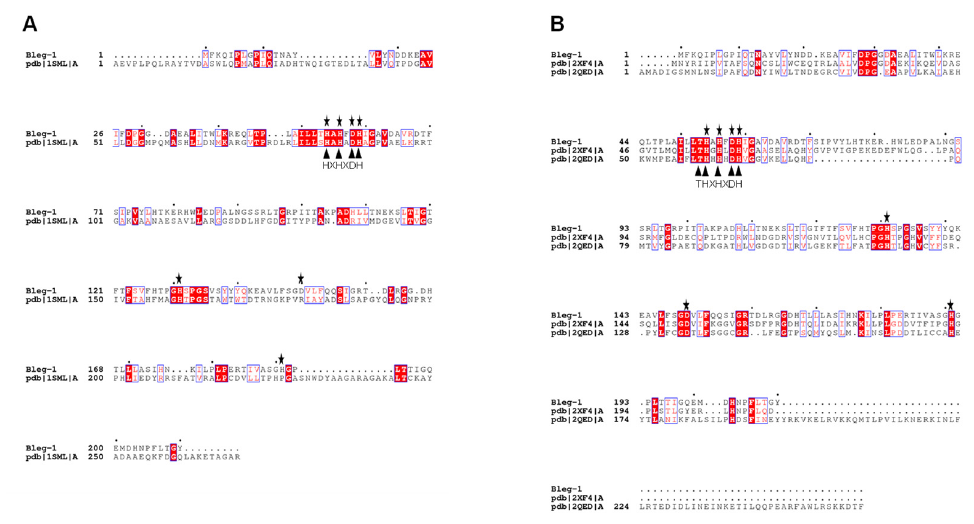
Figure 3. Pairwise sequence alignment of BLEG-1 with ( A ) L1 B3 MBL from Stenotrophomonas maltophilia (PDB ID: 1SML, chain A); and multiple sequence alignment of BLEG-1 with ( B ) YcbL, an unusual GLXII from Salmonella enterica (PDB ID: 2XF4, chain A) and GloB GLXII from Salmonella enterica subsp. enterica serovar Typhimurium str. LT2 (PDB ID: 2QED, chain A). Highly conserved residues are highlighted in red color. Conserved protein motif are marked with black triangles. Zinc coordinating residues in BLEG-1 are marked with stars.